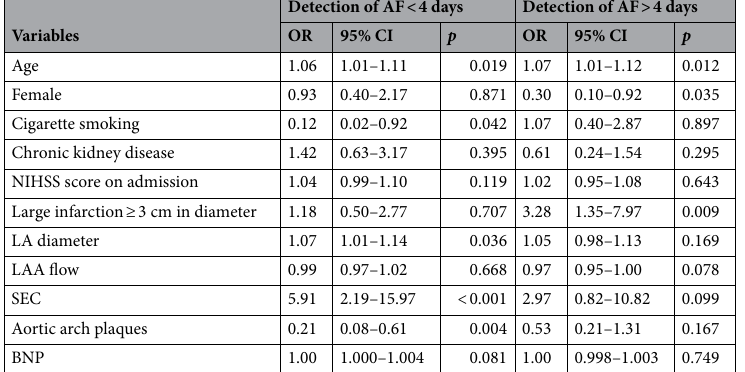
Table 2. Multinomial logistic regression analysis predicting factors associated with AF development ≤ 4 days and > 4 days. LAA flow was defined an average of LAA inflow and out flow. AF = atrial fibrillation; NIHSS = NIH Stroke scale; LA = left atrium; LAA = left atrial appendage; SEC = spontaneous echocontrast; BNP = brain natriuretic